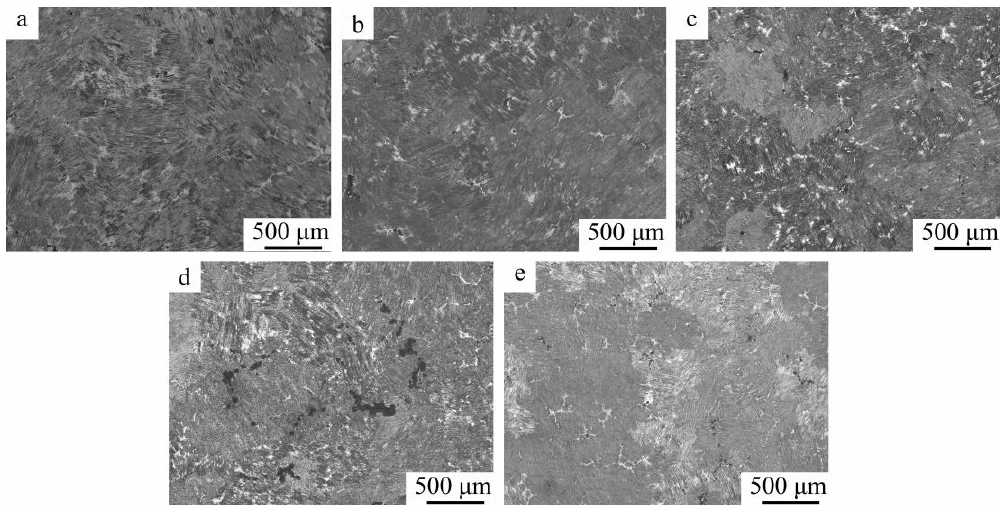
Figure 5. Optical microstructure of test casting ( a – e ) were from the center hole to the outer edge, and the interval between the two samples measured 20 mm.